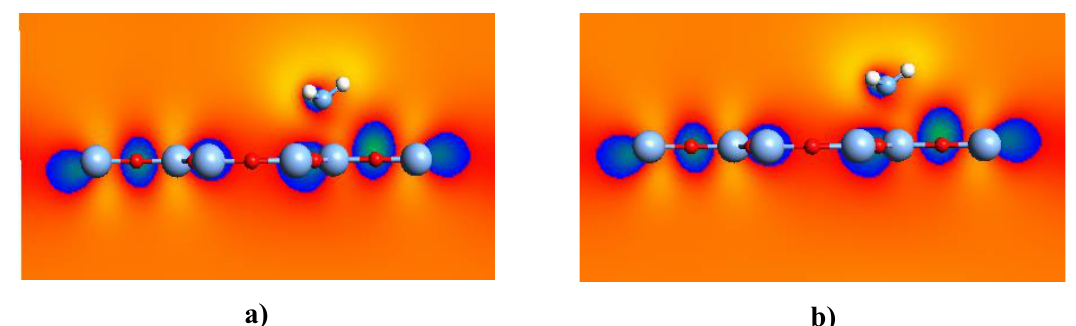
Figure. 6. Electrostatic potential difference contour plot of a) NH